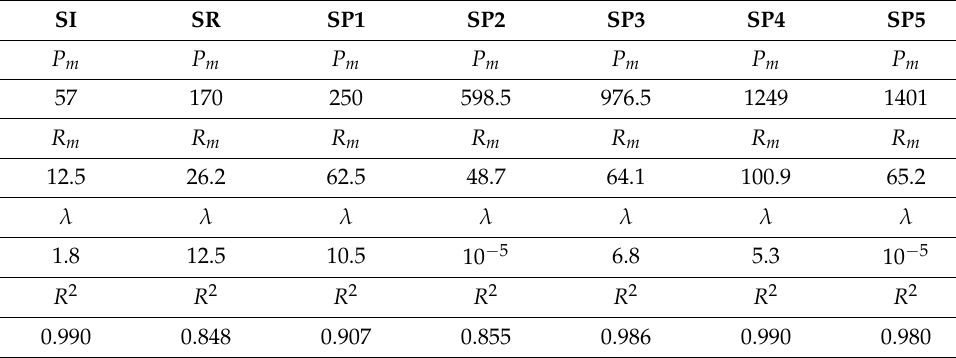
Table 5. Parameters of Gompertz model (Equation (8)) obtained from the interpolation of the